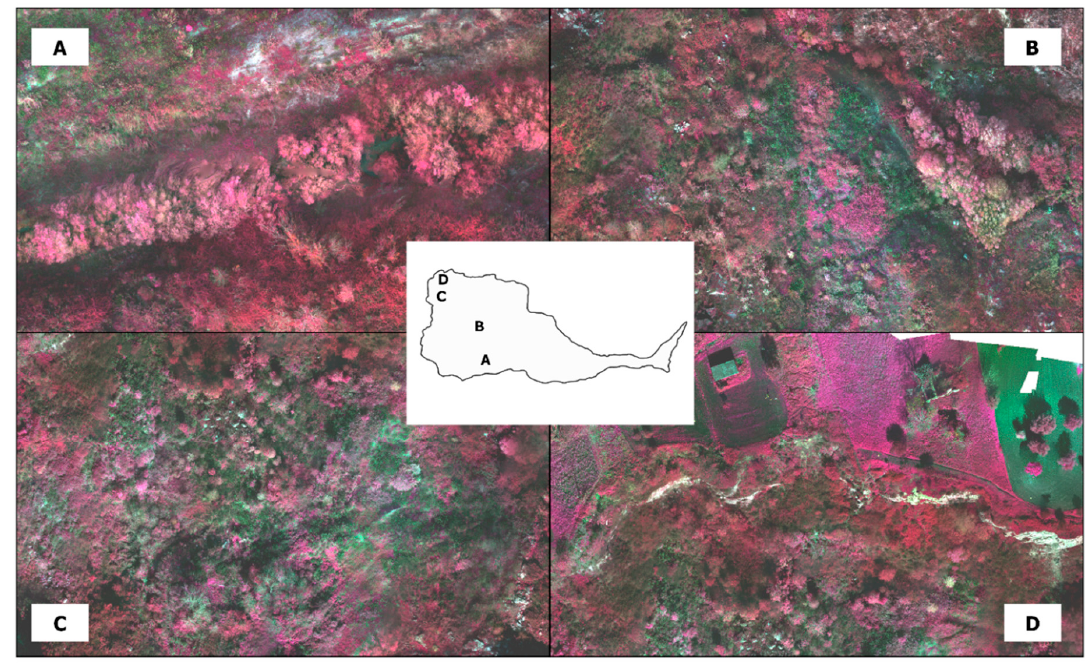
Figure 13. Details of four peculiar sectors of the landslide depicting di ff erent vegetation behavior that could be related with local dynamics.